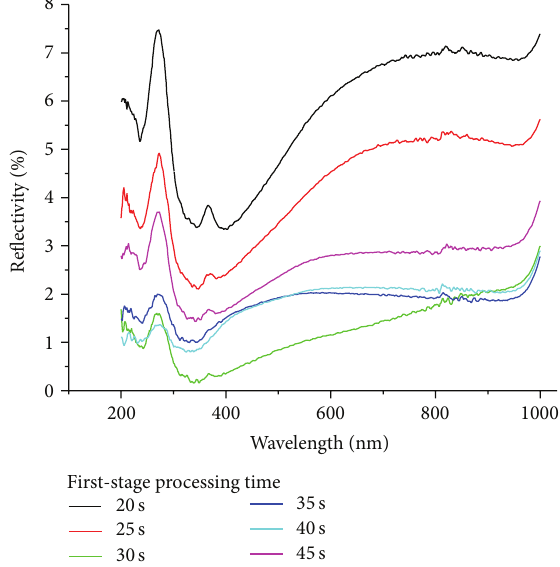
Figure 4: Reflectivity of the fabricated micronanohybrid structures subjected to the proposed two-stage MAE for the light spectrum of 200–1000